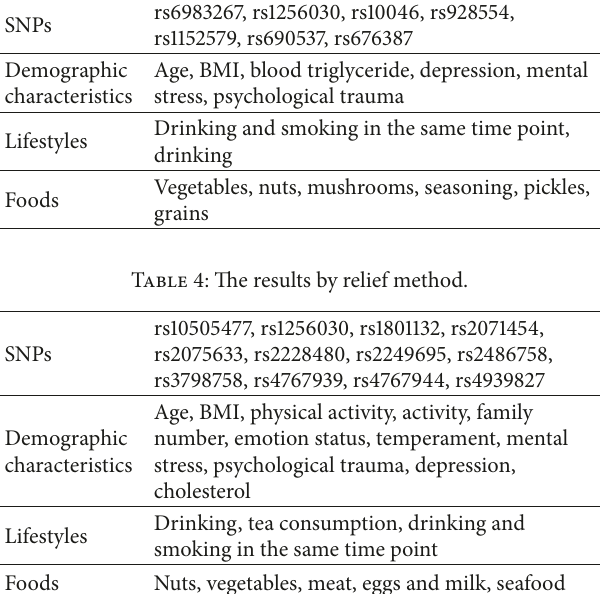
Table 3: The results by entropy method.